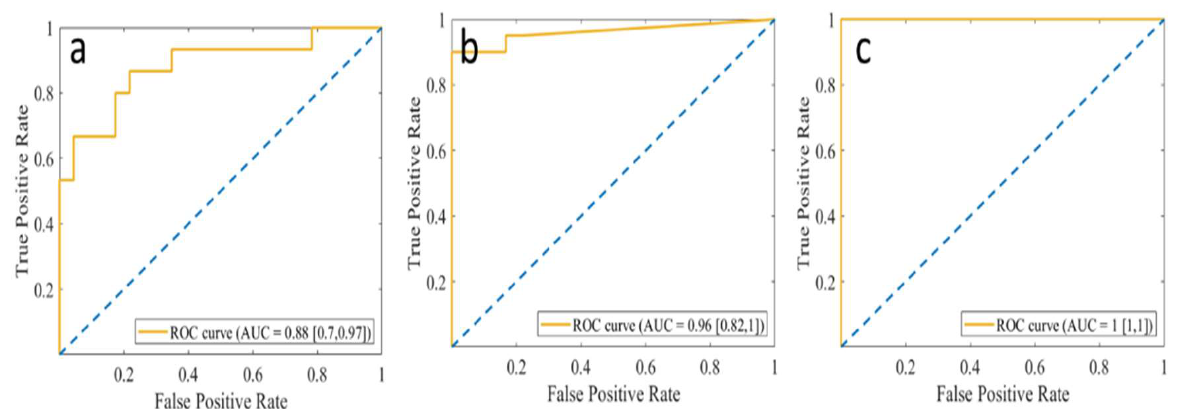
Figure 5. ROC curves of (a) EZ disruption, (b) IRC, and (c) SRF. Blue dotted lines indicate AUC = 0.5. EZ: ellipsoid zone; IRC: intraretinal cystoid fluid; SRF: subretinal fluid.